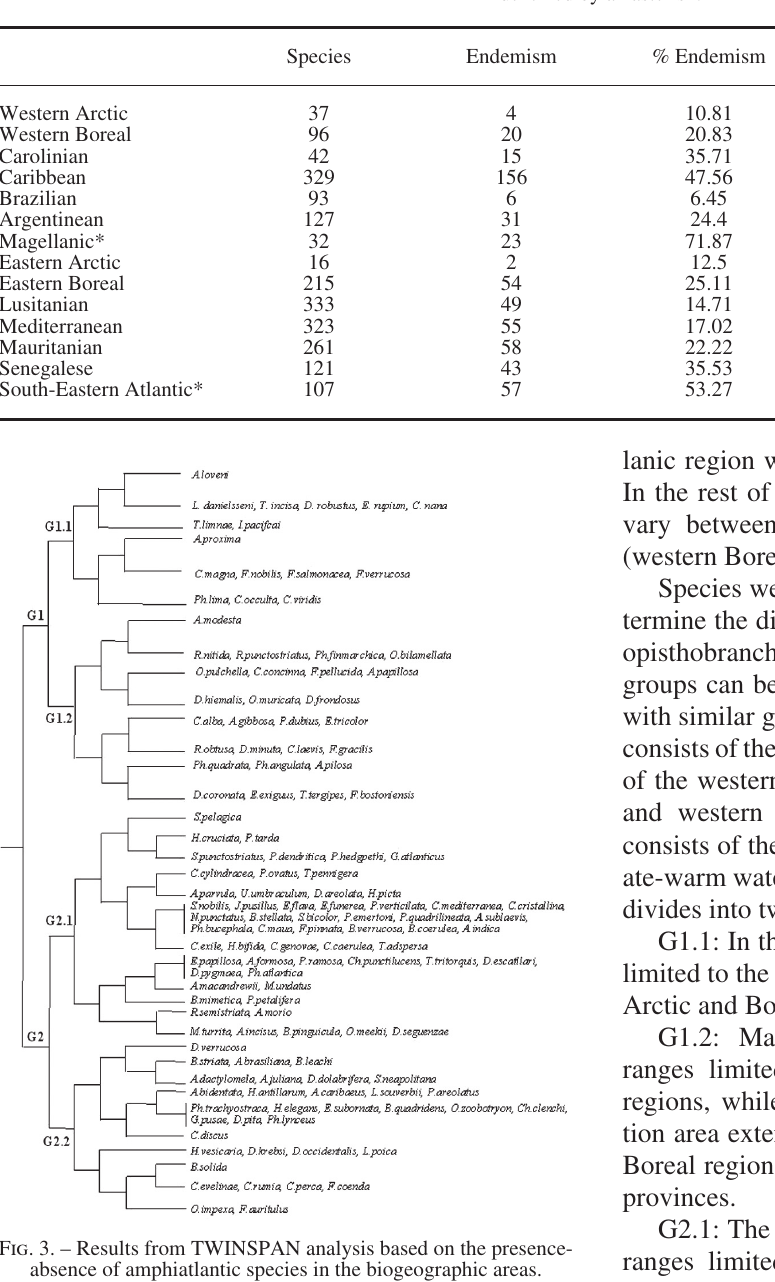
Table 2. – Number and percentage of endemic and amphiatlantic species for each faunistic area. Areas influenced by adjacent oceans are identified by an asterisk.